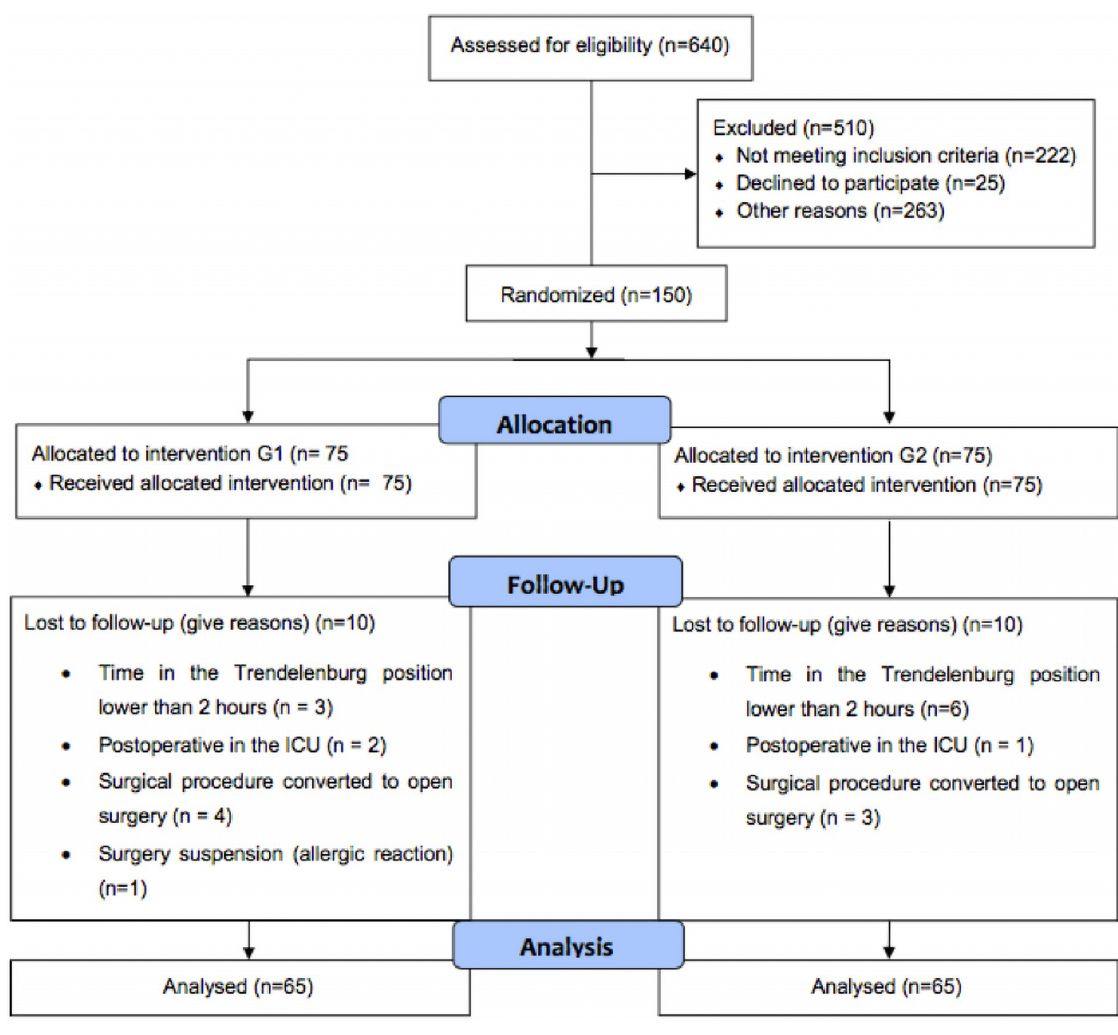
Fig 1. Flowchart of the